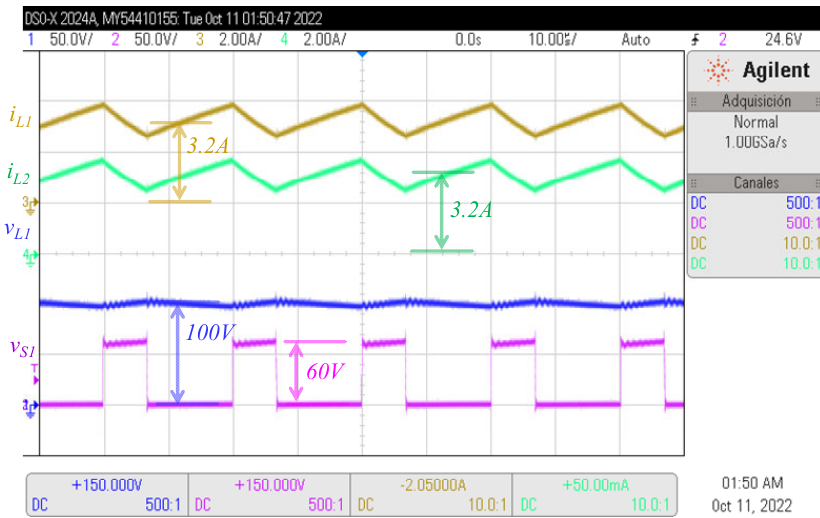
Figure 18. Current through inductors, output voltage, and the voltage across s 1 .